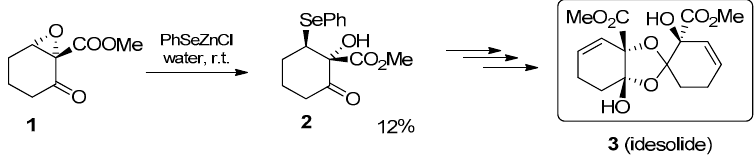
Figure 8. PhSeZnCl in the total synthesis of idesolide.